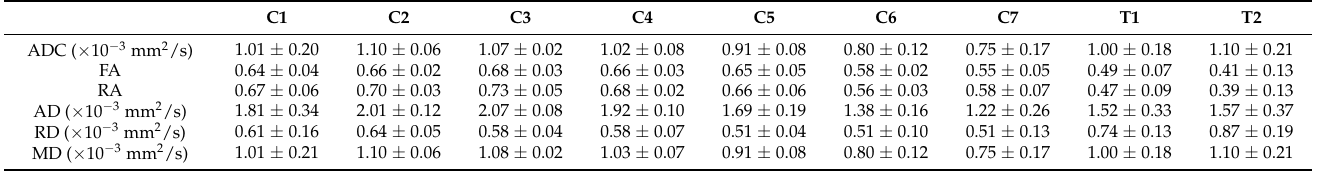
ADC ( × 10 − 3 mm 2 /s) 1.01 ±